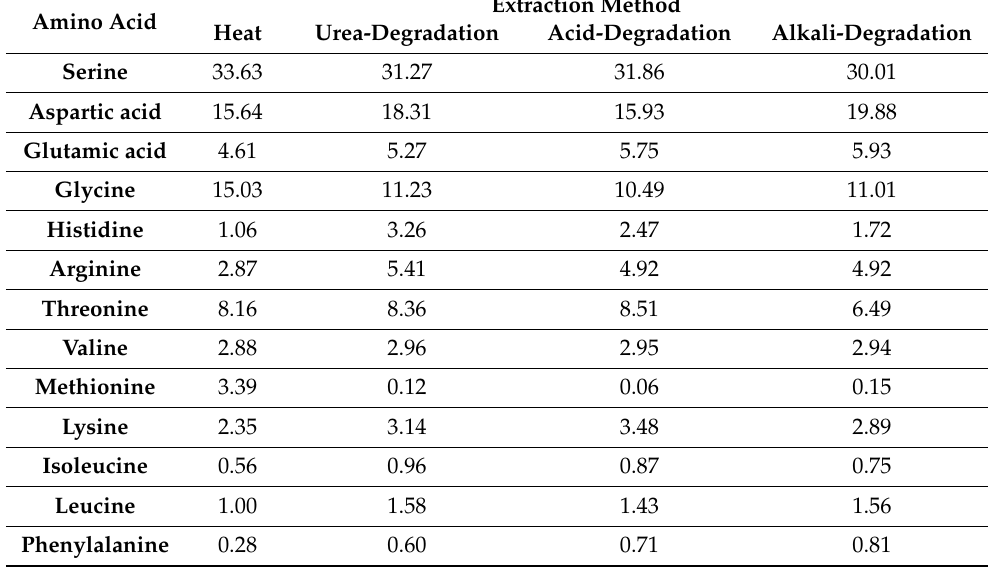
Table 3. Composition of the amino acid (in mole%) of silk sericin from B. mori extracted using various methods. Adapted from [56].